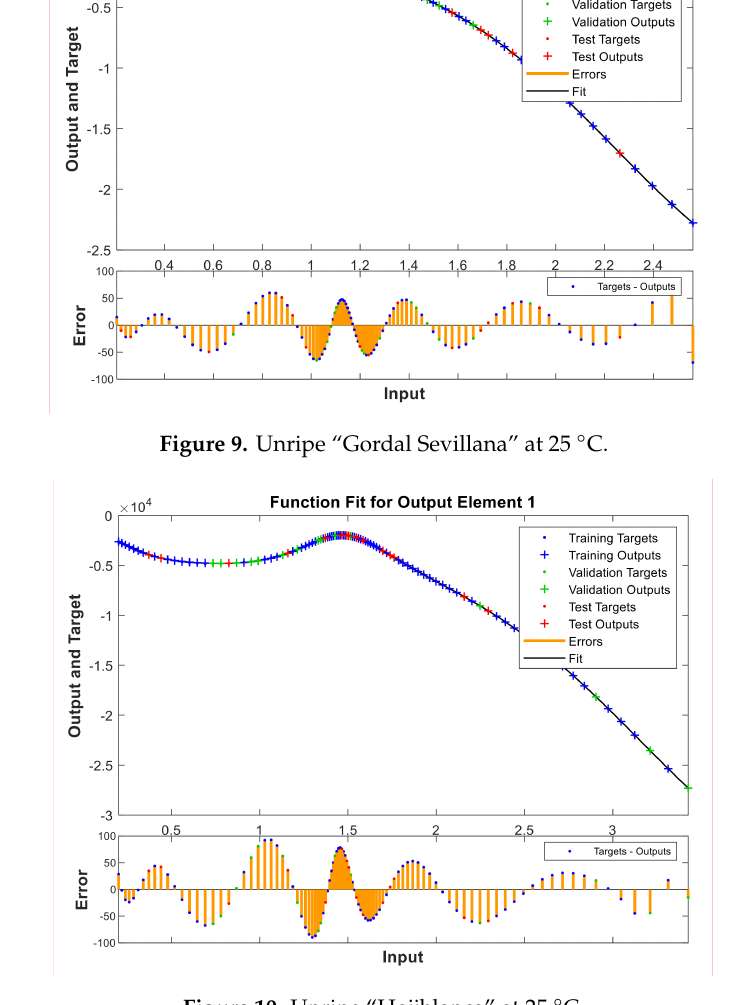
Figure 10. Unripe “Hojiblanca” at 25 ◦